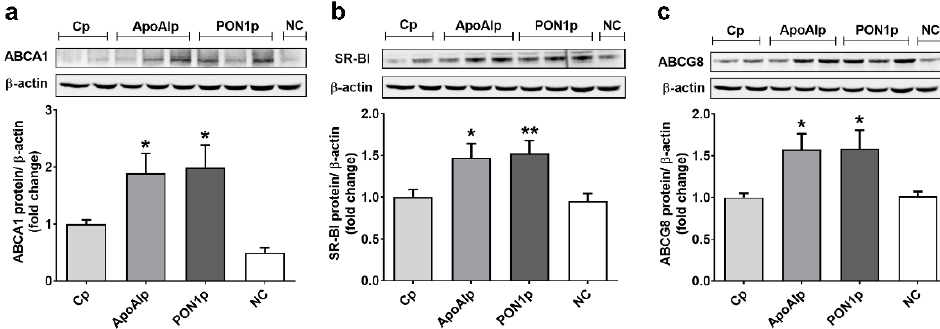
Figure 3. Overexpression of ApoAI and PON1 determines the increase of lipid transporters protein expression in Caco-2 cells. ( a ) ABCA1, ( b ) SR-BI, and ( c ) ABCG8 protein expression relative to β -actin (representative blot and densitometric analysis). Cp, control CRISPR activation plasmid; ApoAIp, CRISPR activation plasmids for ApoAI; PON1p, CRISPR activation plasmids for PON1; NC, negative control–untransfected Caco-2 cells. All data are expressed as fold change versus Cp and presented as mean ± SEM of 3 independent experiments. * p < 0.05, ** p < 0.01 vs. Cp.